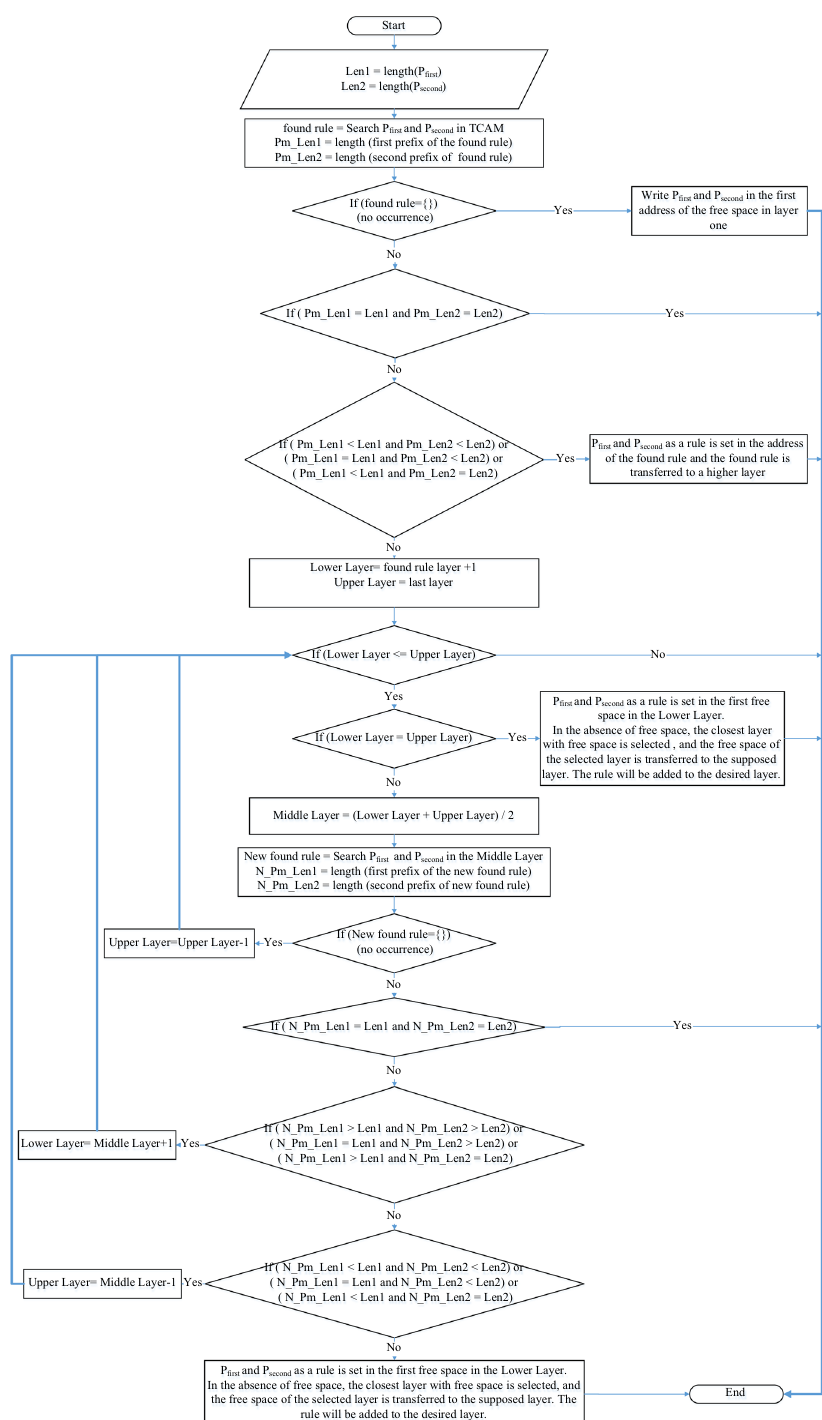
Fig. 6 The Flowchart of adding a rule in the second